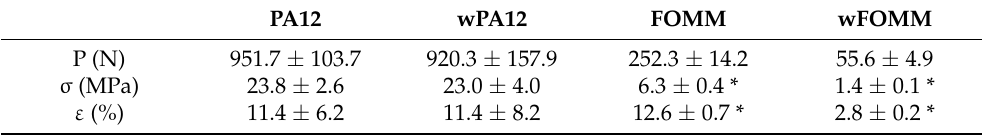
Table 5. Tensile strength results obtained for dry and wet printed specimens.